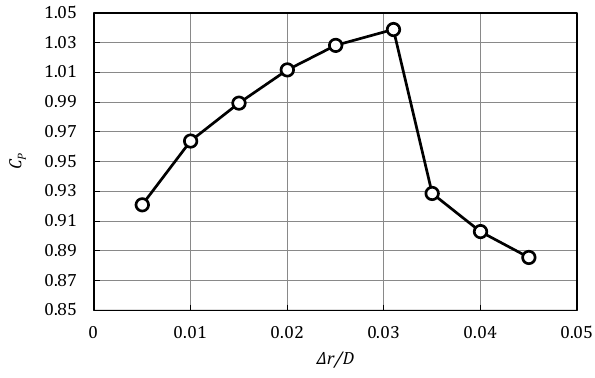
Figure 9. Variation of C P with (cid:49)r/D ( C T , rotor = 0 . 763; α = 28 ◦ ; and z/c = 0 . 103).